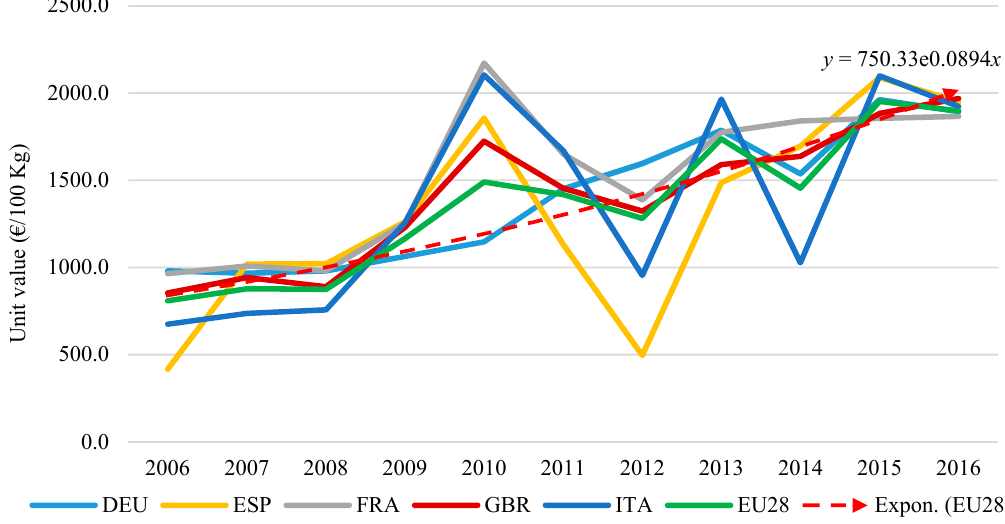
Figure 1. Price development estimated as average current prices of products imported to the EU (2006–2016).